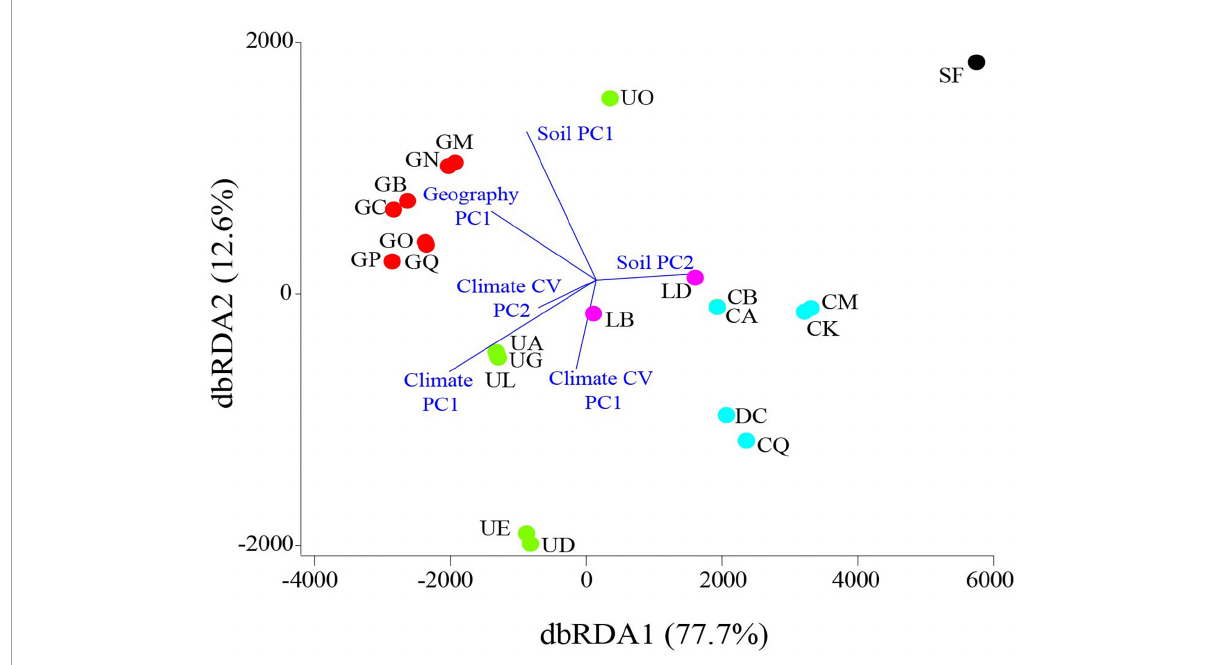
FIGURE3 Distance-based Redundancy analysis (dbRDA) ordination diagram for the geography PC1, soil PC1 and PC2, climate PC1, and the climate CV predictors. The location scores on the first two dbRDA dimensions are denoted by region-colored circles (legend in Figure 1 ), and the vector overlays are denoted in blue. The size and direction of each vector is representative of the strength and direction of influence of it in the